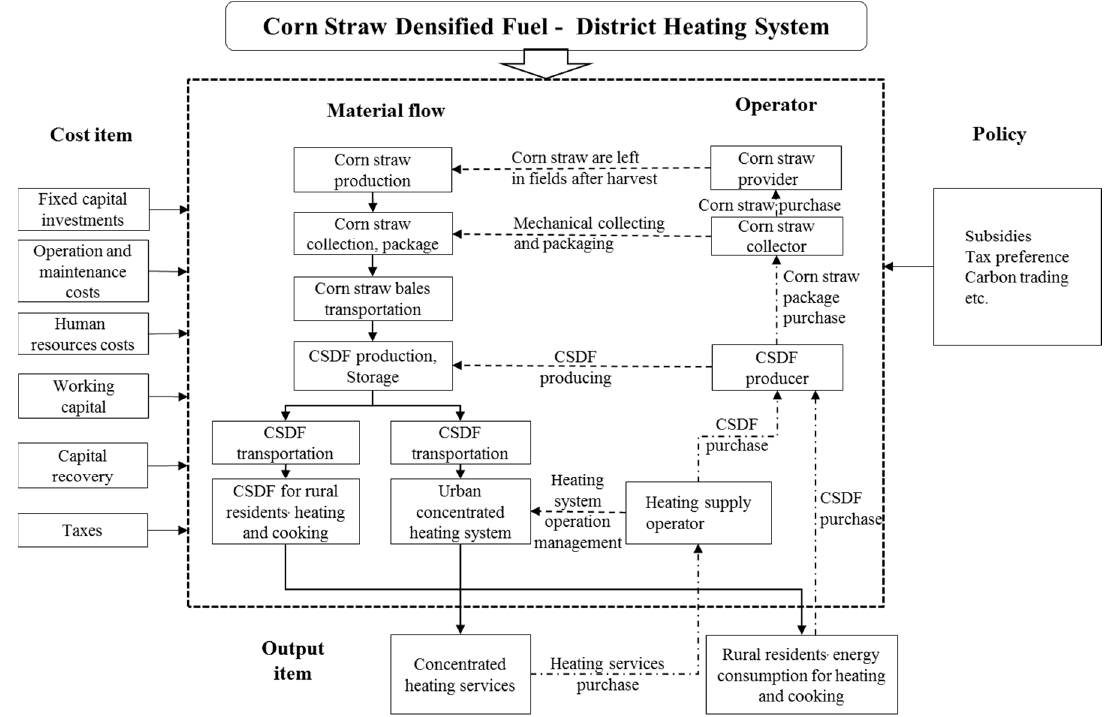
Figure 1. System boundary and correlations of a CSDF-DHS.